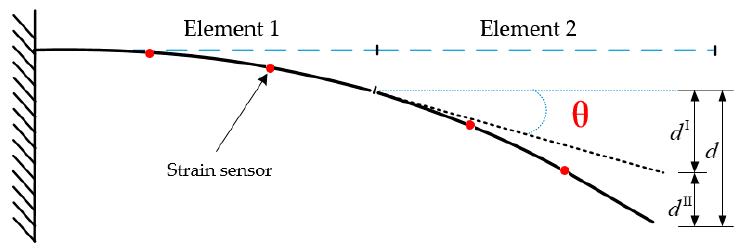
Figure 1. Structural deformation and displacement.